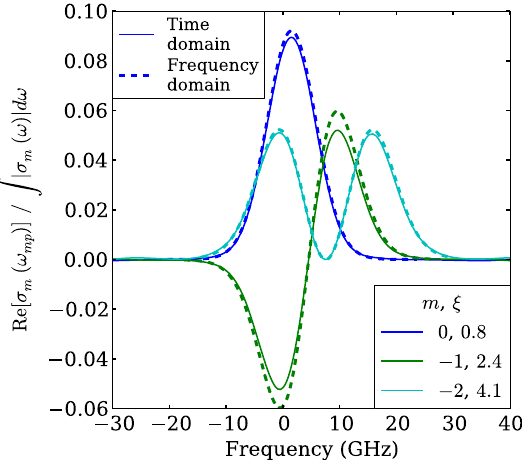
FIG. 9. Transverse bunch spectra for the lengthened Gaussian bunch case for the dominant mode at three different chromatic- ities. Time domain and frequency domain results are compared.